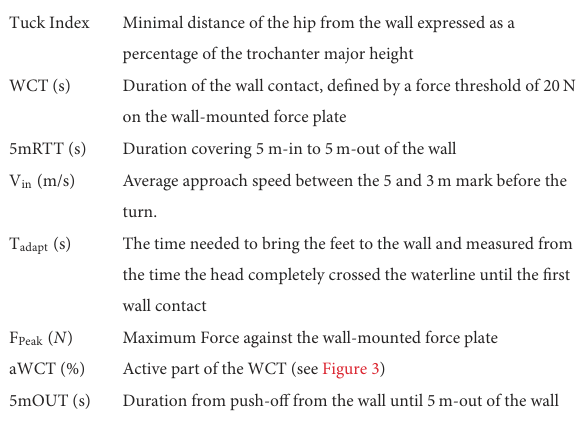
away (far) from the wall than in the reference trials. Analogous TABLE 2 Description of the variables of